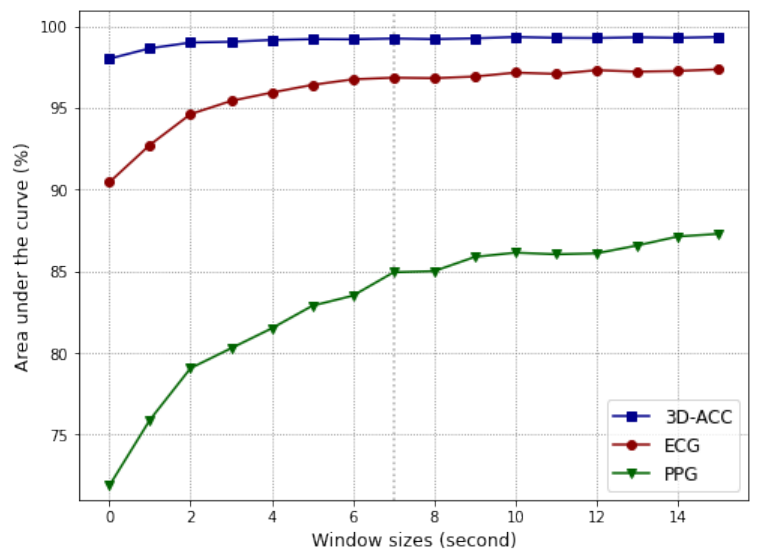
Figure 3. Comparison between different window sizes for 3D-ACC, PPG, ECG signals. X-axis: Window sizes represented in seconds. Y-axis: Area under the receiver operating characteristic curve after train and test random forest models.